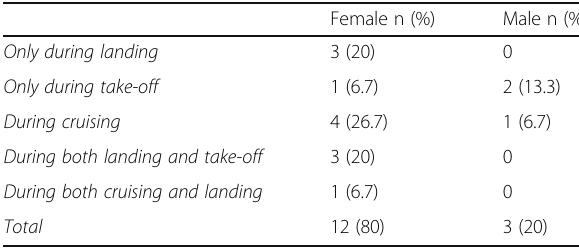
Table 3 Headache onset with respect to flight